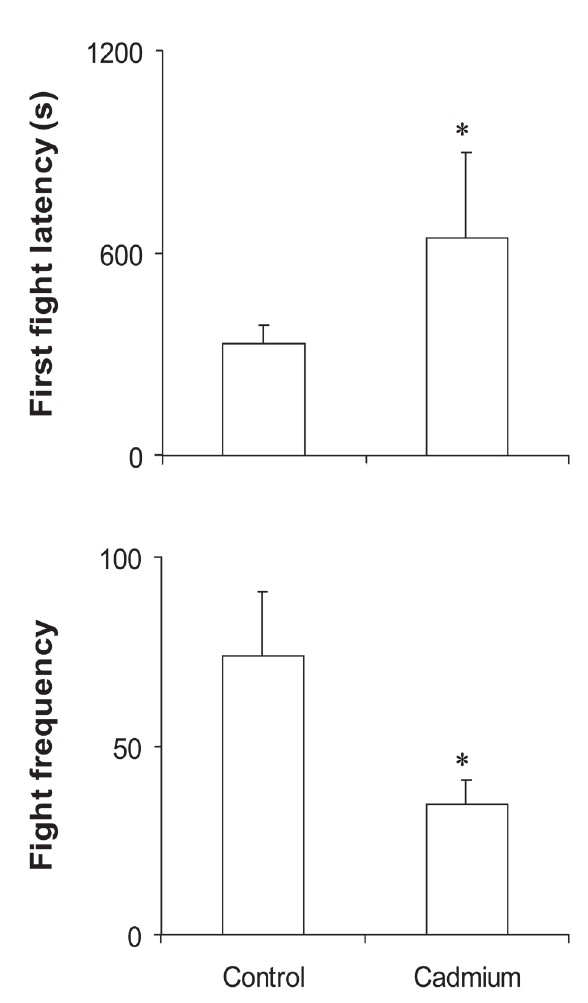
Fig. 1. Effects of cadmium exposure on aggressiveness parameters of Nile tilapia. Values are means (± SD). * = Statistically different from control.